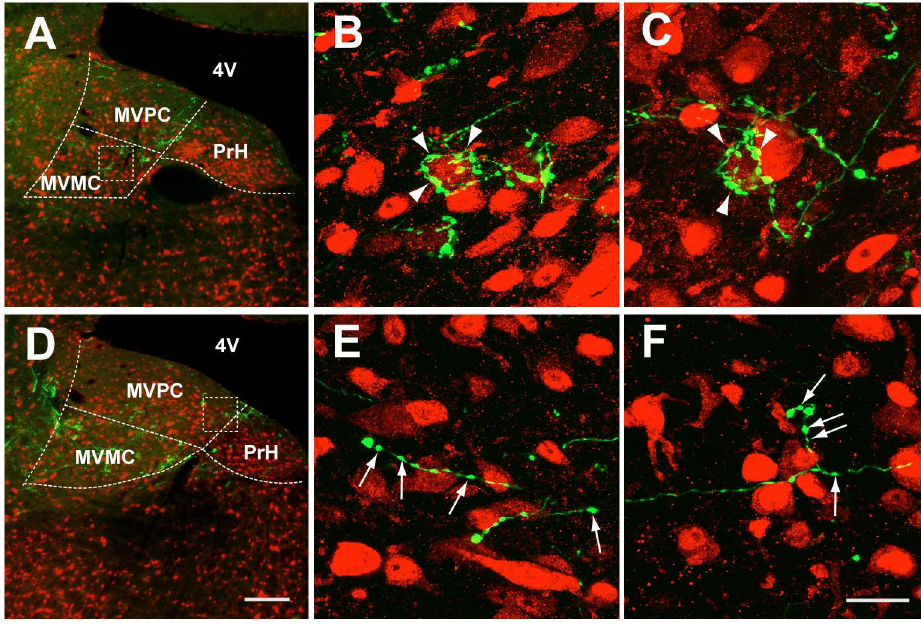
Fig 3. Two distinct types of FL P-cell axonal boutons observed in MVN/PrH (case (#) 94R). A – C , Merged images of GFP-fluorescent FL P-cell axonal boutons (green) and anti-NeuN-labelledsomata (red) of MVN neurons. In A , anterogradely labeledFL P-cell axonal boutons were observed in the magnocellular MVN, in which the somata and proximal dendrites of MVN neuronswere surrounded by a small group of axons, showingbasket like structures (arrowheads in B and C ). D – F , Similar to A – C , but for those observed in the parvocellular MVN/PrH, in which axonal boutons showing en passant structures were dominantly observed (arrows in E and F ). MVMC, mgnocellular NVN; MVPC, parvocellular MVN; PrH, prepositus hypoglossi nucleus; 4V, fourth ventricle. Scale bars, 200 μ m ( A and D ) and 20 μ m ( B , C , E and F